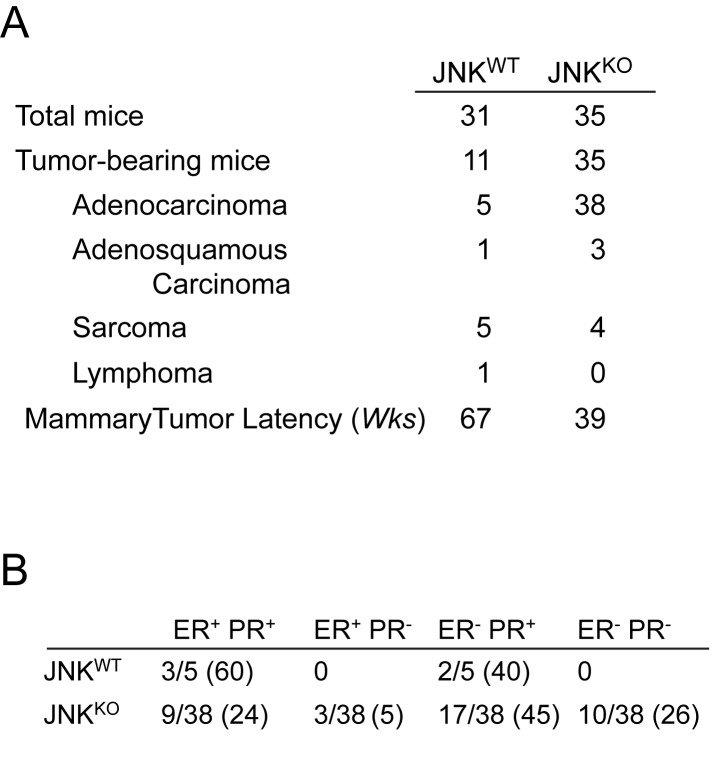
Tumors in JNKKO mice are primarily adenocarcinomas and display a spectrum of hormone receptor expression patterns.(A) The JNKWT and JNKKO mouse cohorts are summarized. (B) Adenocarcinomas from JNKWT and JNKKO mice were stained for PR and ER and scored for expression. Numbers in parentheses indicate percentages.